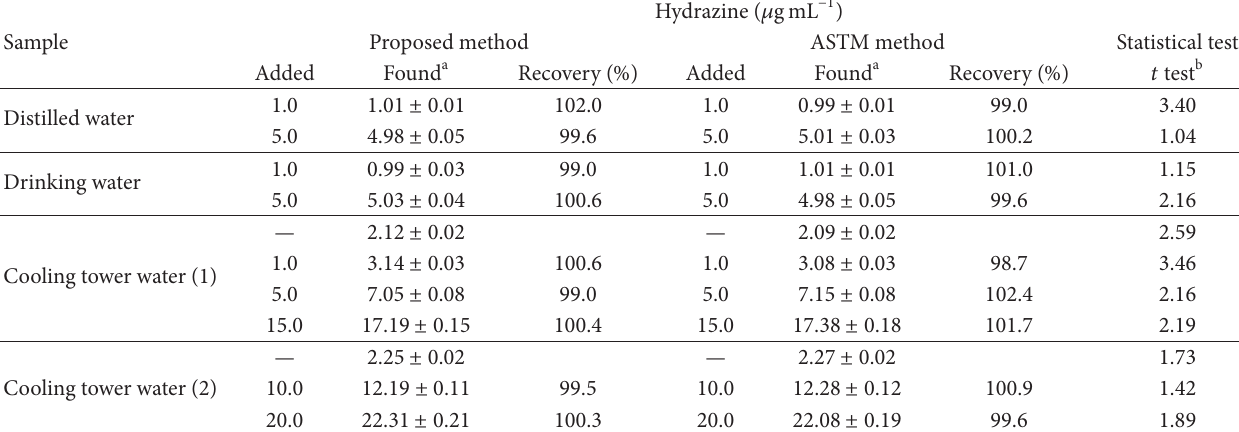
T 3: e recovery results on the determination of hydrazine in the different water samples using the proposed method and the standard ASTM method.